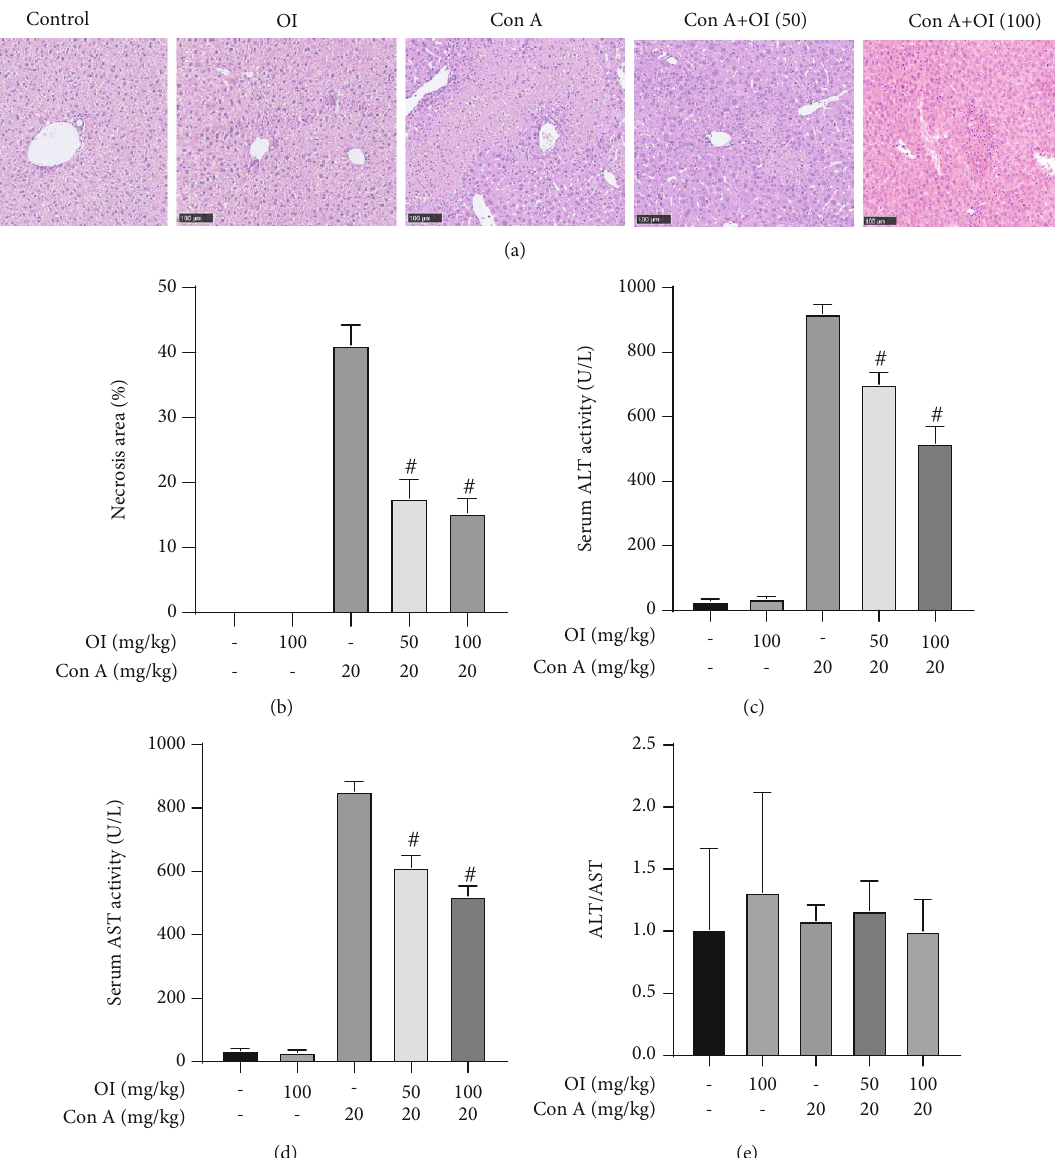
Figure 1: OI attenuated Con A-induced hepatic damage in mice. (a) Representative hepatic micrographs in control group, OI group (100mg/kg), Con A group (20 mg/kg), low-dose OI group (OI: 50mg/kg+Con A: 20 mg/kg), and Con A+OI group (OI: 100 mg/kg+Con A: 20 mg/kg). Then, we evaluated the (b) necrotic area, serum activities of (c) ALT and (d) AST, and (e) ALT/AST ratio of each group. Data are expressed as mean ± SEM ( n = 6 ). # p < 0 : 05 vs. Con A